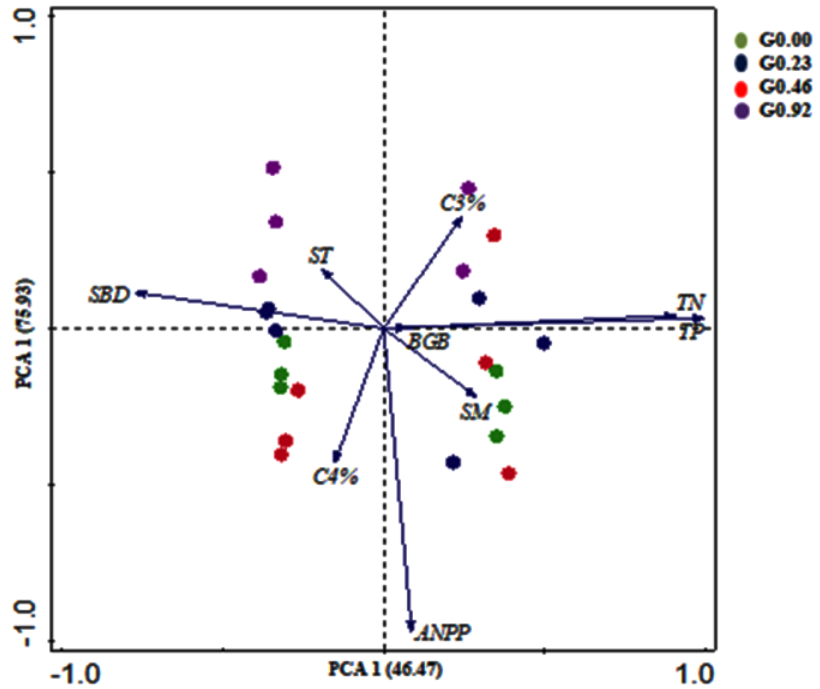
Figure 9. PCA ordination of 24 samples with five environmental variables and three biological variables in the Hulunber grassland, China. The vectors shown represent the major explanatory environmental variables. SBD, soil bulk density; SM, soil moisture; ST, soil temperature; TN, total nitrogen; TP, total phosphorus. The biological variables: BGB, belowground biomass; C4%, C4 species proportion; C3%, C3 species proportion. The circles represent plots.